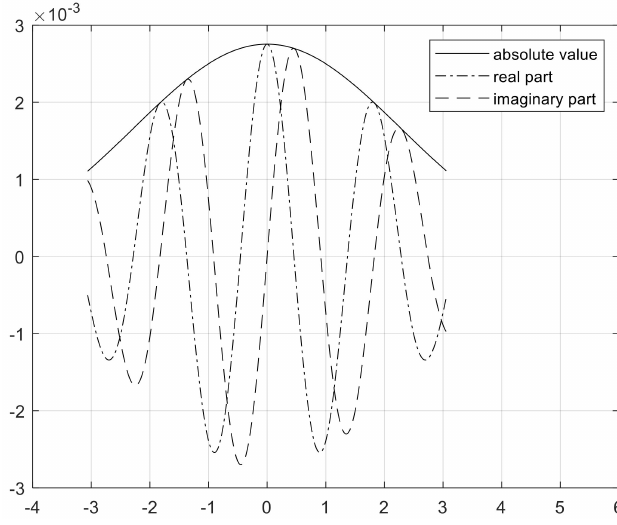
Figure 4. Morse wavelet with γ = 3 and P 2 =